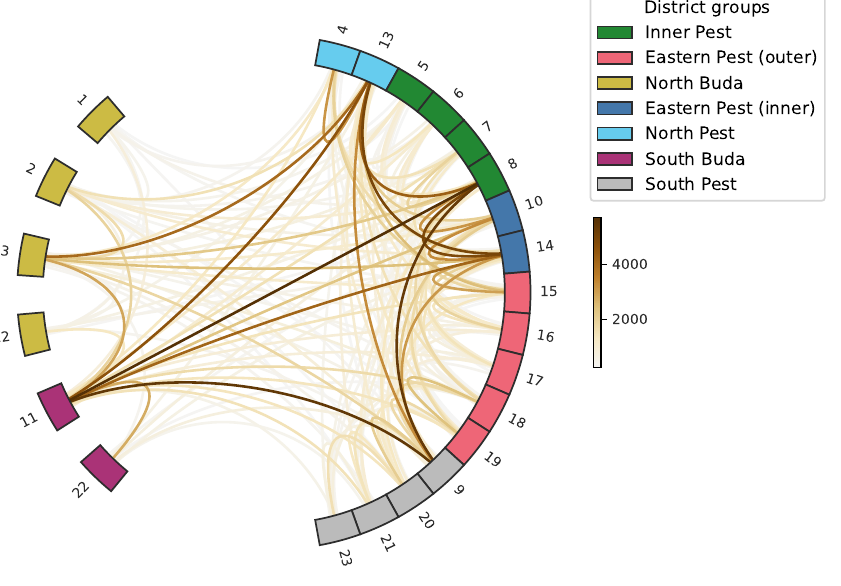
Figure 11. Connection by commuters between Budapest districts (numbered nodes) based on the home and work locations. A link represents how strong the commuting between two districts is. The weak links are omitted to improve visibility. The district nodes are colored by the district